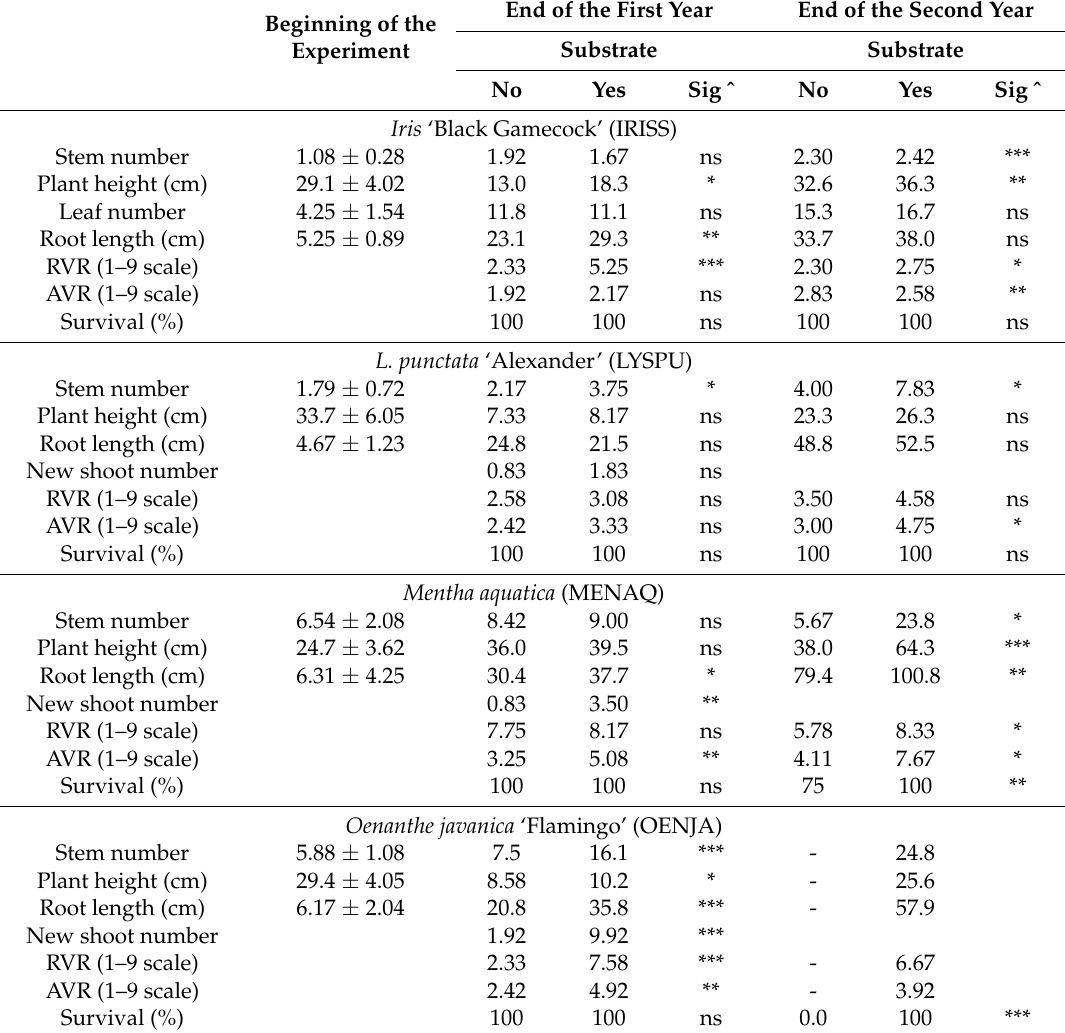
Table 3. Plants characteristics at the beginning of the experiment, at the end of the first year, and at the end of the second